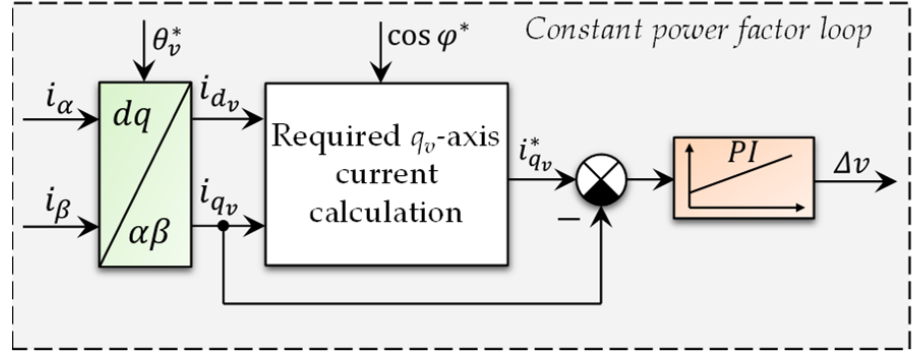
Figure 16. Block diagram of the constant power factor loop.